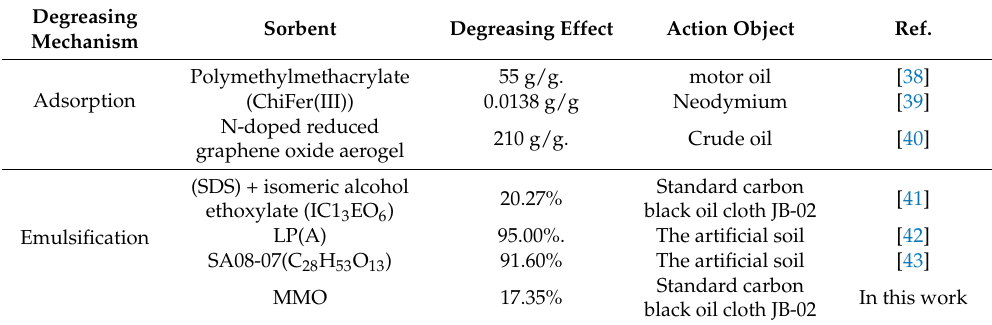
Table 2. The comparison of the degreasing effect of several sorbents found in the literature.